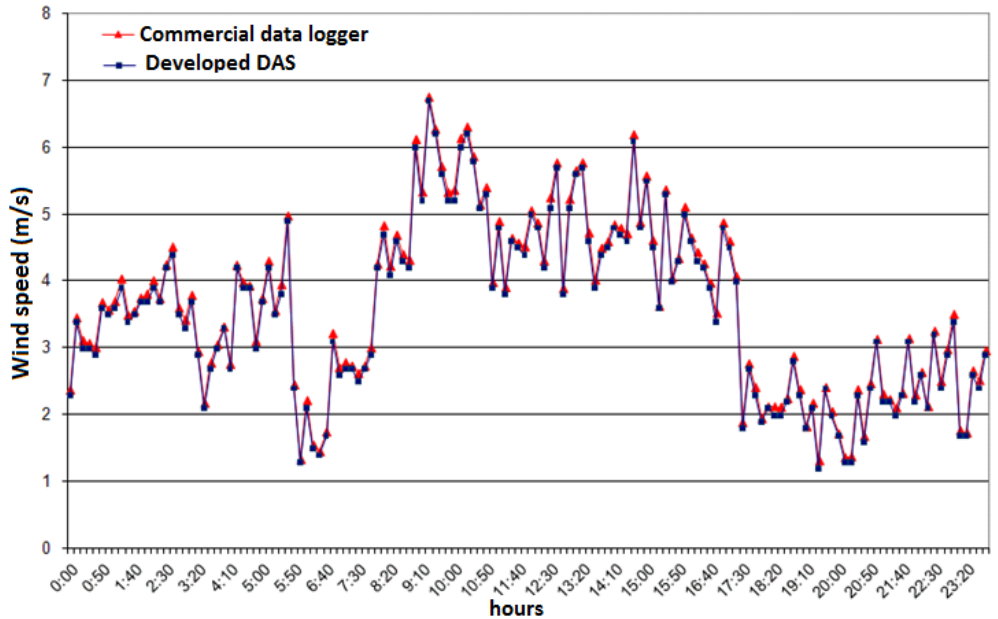
Figure 6. Wind speed data collected by the developed DAS and compared with the same data collected by a commercial data